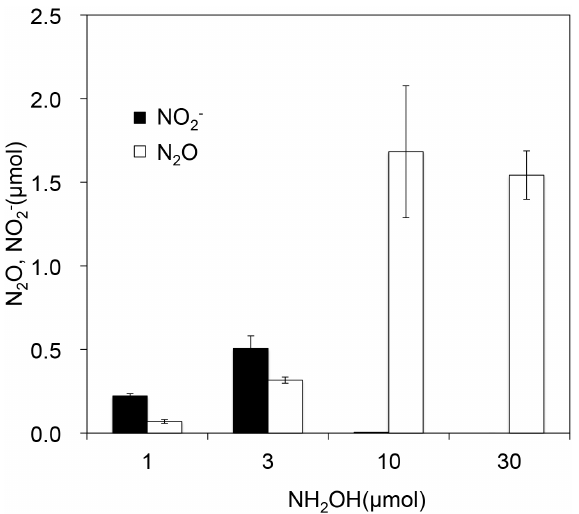
Figure 1. Amounts of N 2 O and NO − produced by HAO extracted 2 from N. oceani under different substrate (NH 2 OH) concentration (expressed as amount in the reaction vessel). The error bar indicates standard deviation for three